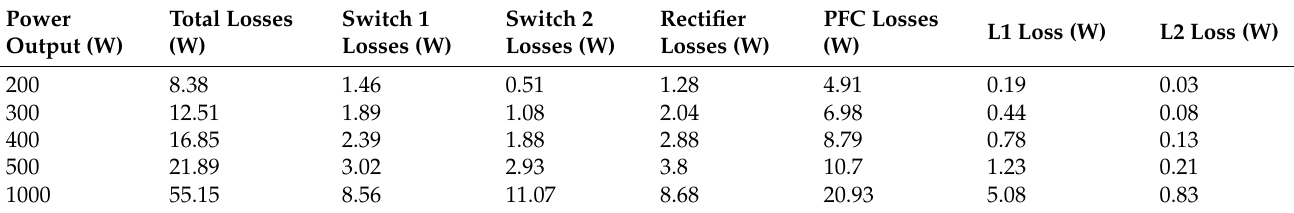
Table 2. Simulated single cell buck PFC